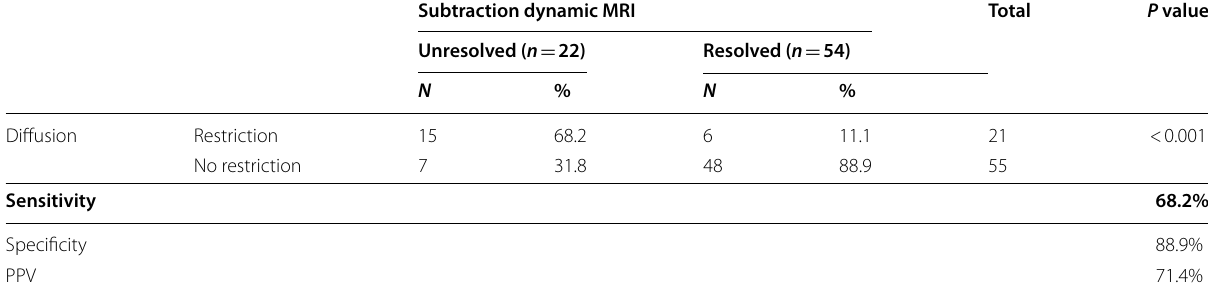
Table 5 Diagnostic indices of diffusion MRI using subtraction MRI as gold standard